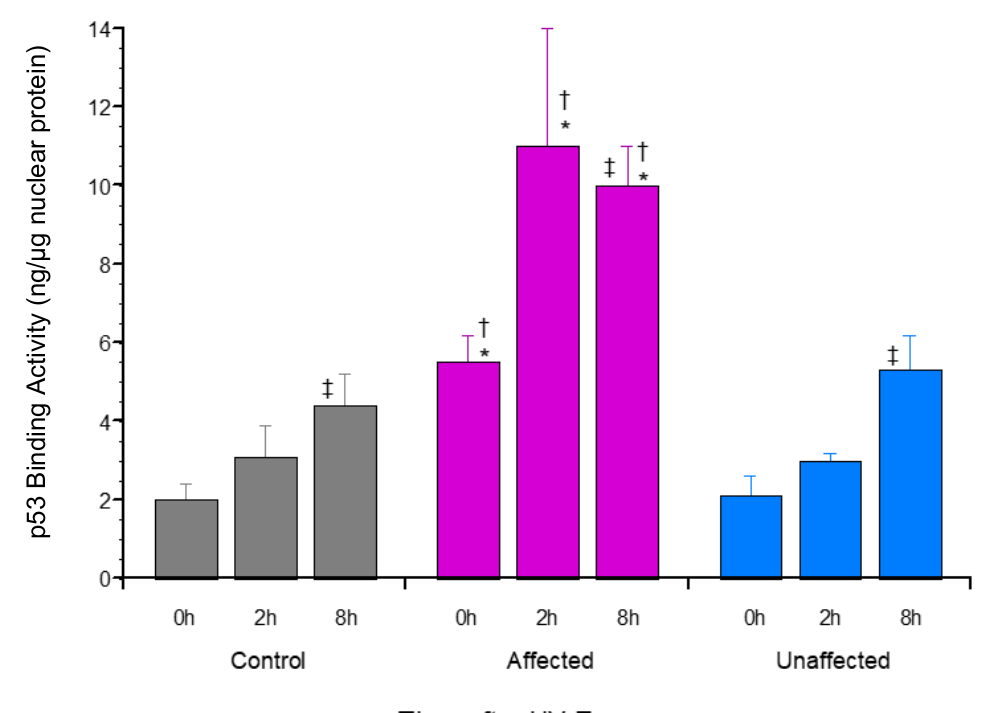
Figure 3. p53 promoter binding activity by dFb from affected LFS compared to unaffected or control subjects in response to UV exposure. TF-Detect Human p53 Activity Assay Kit (GeneCopoeia, Rockville, MD, USA) was used to compare amount of consensus p53 promoter binding site activity in nuclear protein extracts from proliferating dFb ± UV irradiation, according to manufacturer’s recommendations ( n = 4: * p < 0.05, affected vs. unaffected dFb; † p < 0.05, affected vs. control dFb; ‡ p < 0.05, vs. -UV irradiation (time = 0 h)).